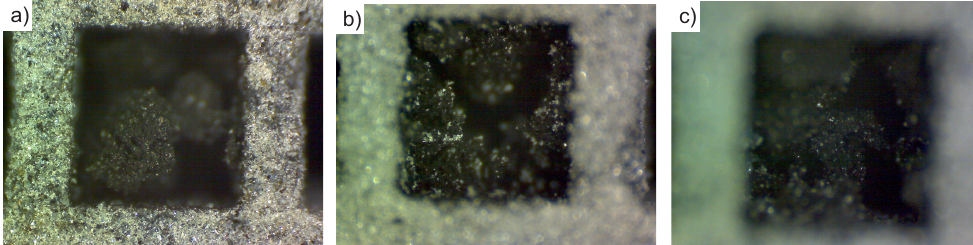
Figure 4. Pictures of soot agglomerates accumulation in the rear end of three inlet channels (21.5 cm from monolith inlet) after water injection in DPF